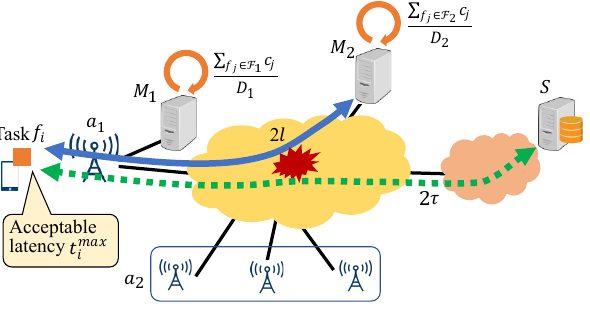
Figure 3. Latency for processing task f i